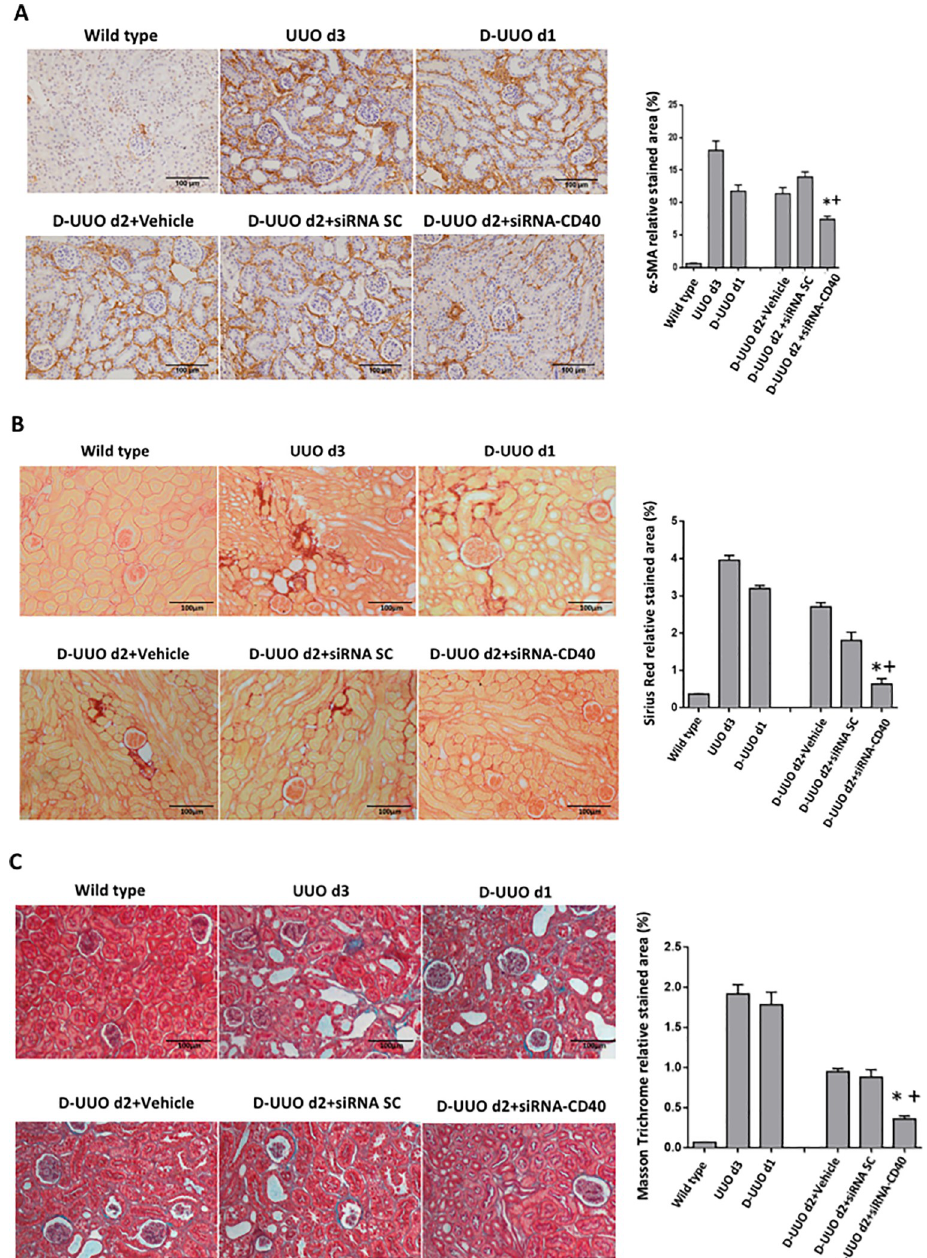
Fig 5. Interstitial fibrosis evaluation of the obstructed kidneys. (A) Representative images of α -SMA (B) Sirius Red and (C) Masson’s trichrome staining. Original magnification 100x. Graphical quantification of α -SMA, Sirius Red and Masson’s Trichrome from each group. Values are obtained as relative stained area (%). ANOVA test; values are means ± SE, � p � 0.05 vs D-UUO d2+Vehicle, + p � 0.05 vs D-UUO d2+siRNA